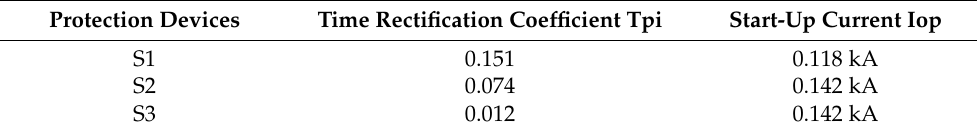
Table 1. Optimal setting parameters of traditional inverse time limit current